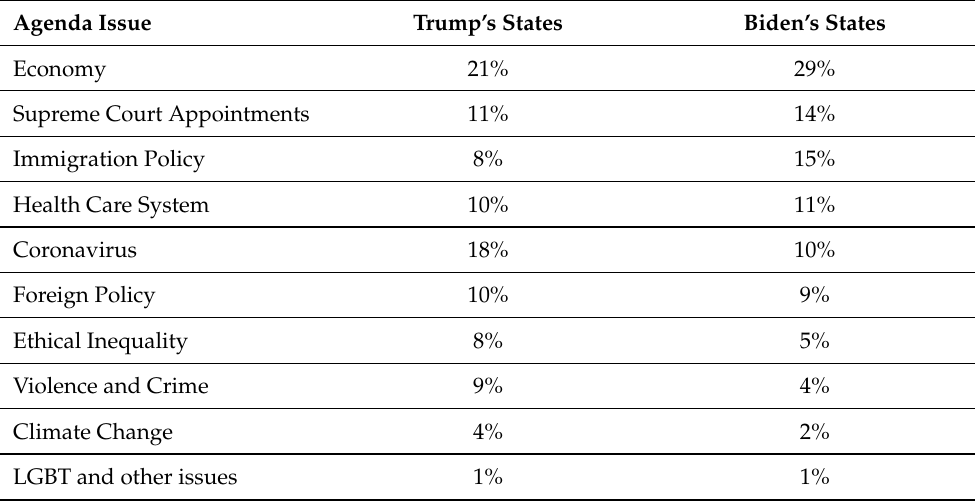
Table 8. Sentiment analysis based on agenda issues, sorted on states won by Biden.